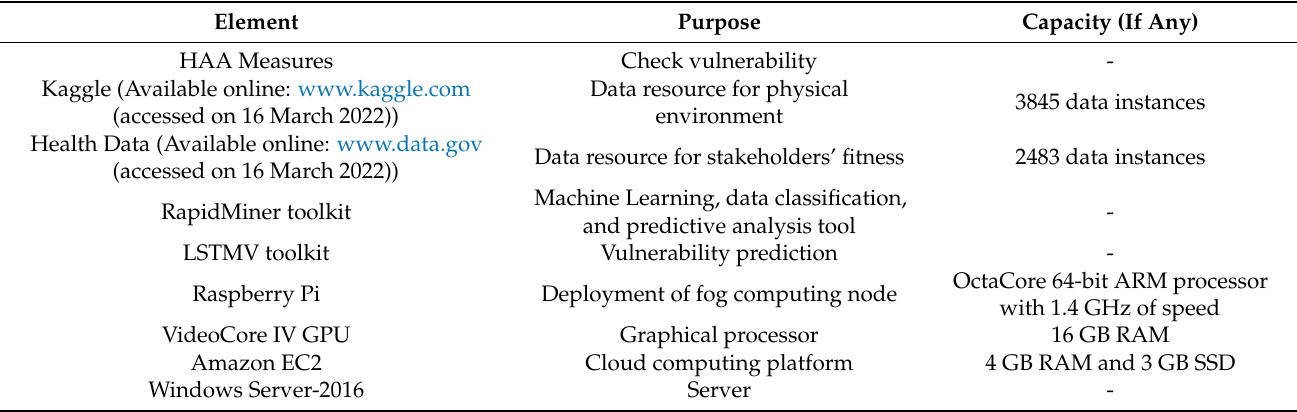
Table 5. The simulation environment and the data